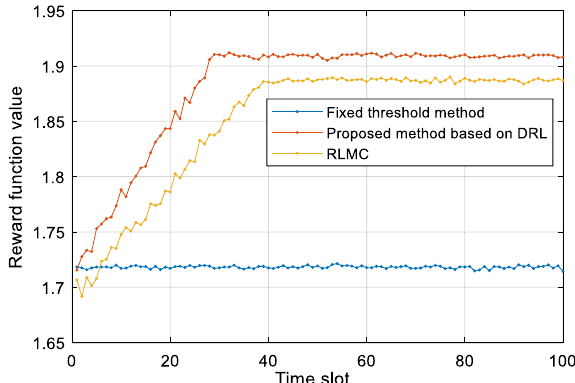
Fig. 18 Average reward function value of each time slot in simulated